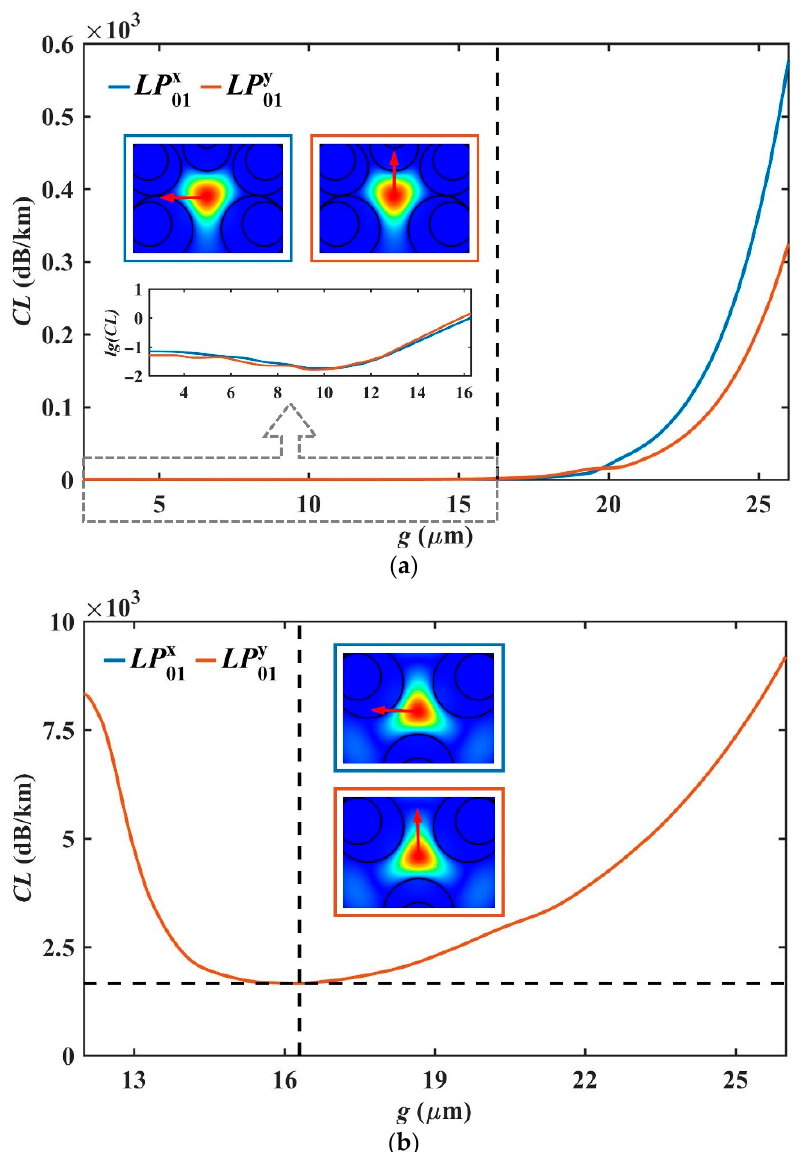
Figure 4. ( a ) Influence of various g on CL of three individual cores (A, B, and C) and the electric field distributions of x-polarization and y-polarization FM for the three individual cores, the direction of red arrows represents the direction of the electric field; ( b ) influence of various g on CL of the individual central core O and the electric field distributions of x-polarization and y-polarization FM for the individual central core, the direction of red arrows represents the direction of the electric field.